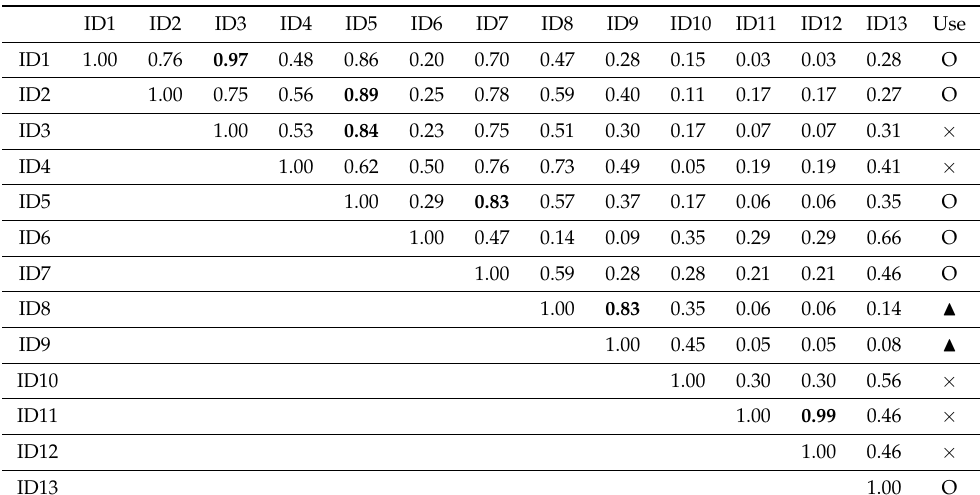
The bold values indicate the high correlation (more than 0.80). O indicates “use”, × means “not use”, and (cid:78) implies “not use due to the extra